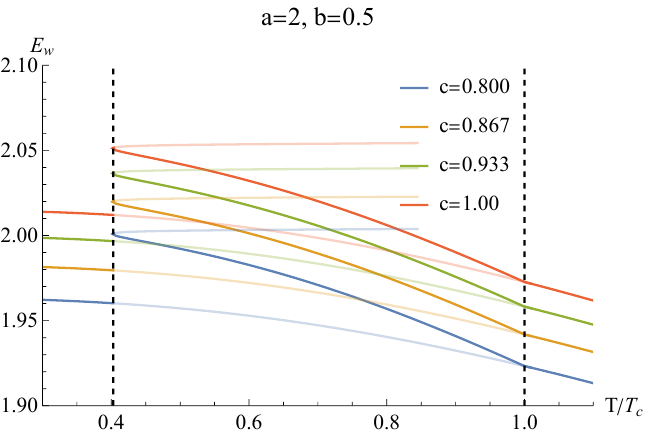
Figure 13 . The EWCS E w versus temperature T/T c when zeroth-order phase transition occurs and we set a = 2 , b = 0 . 5 . The transparent lines represent metastable states and the solid lines represent stables state. The zeroth-order phase transition occurs in T 2